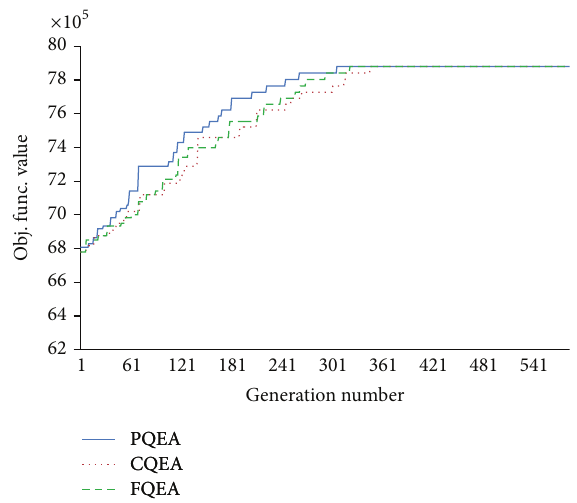
Figure 11: Convergence graph of PQEA, CQEA, and FQEA on COUNTSAT problem size, 𝑛 , being 600.